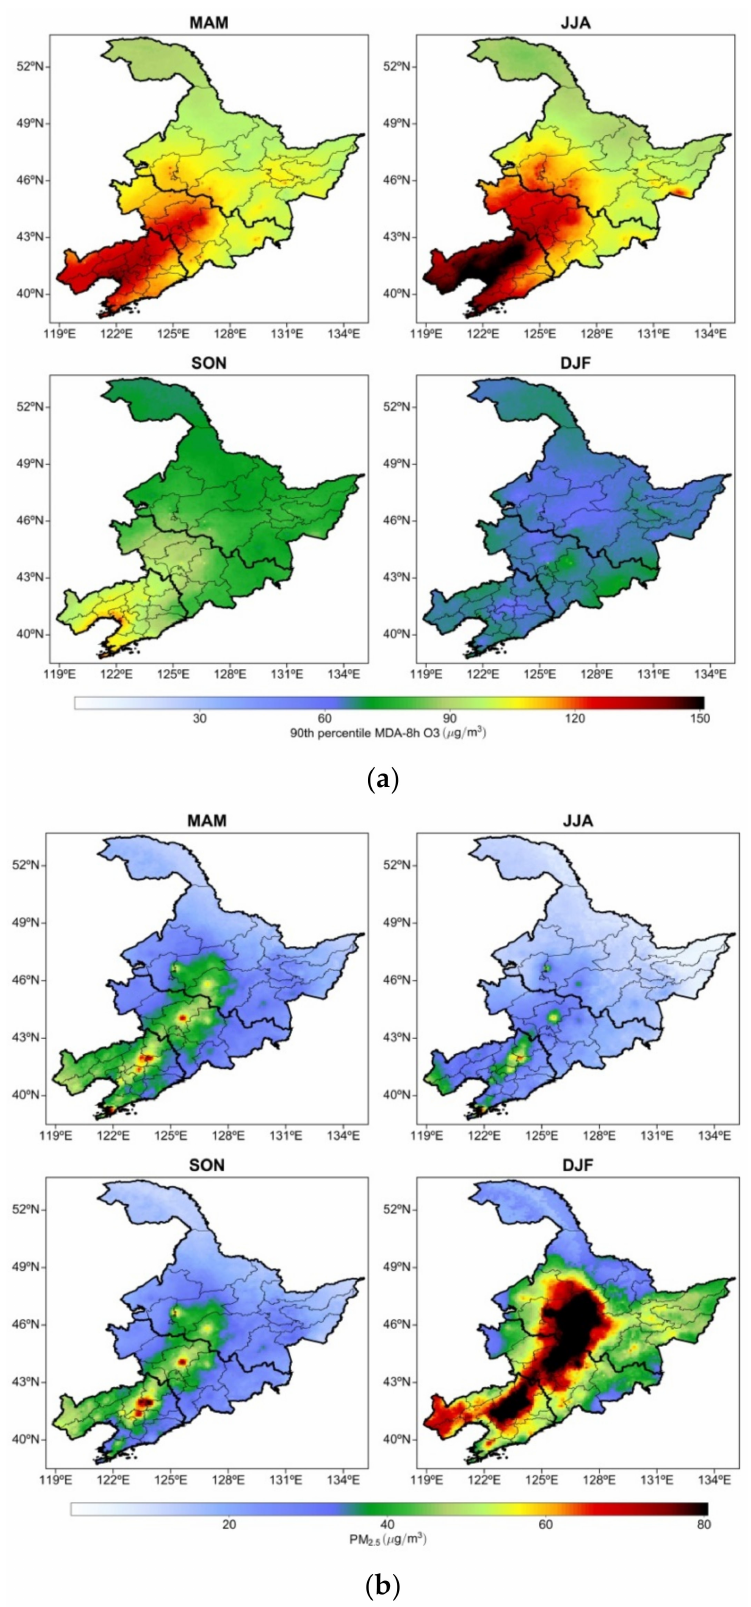
Figure 3. Spatial distribution of mean seasonal concentrations of ( a ) O 3 -8h-90per averaged